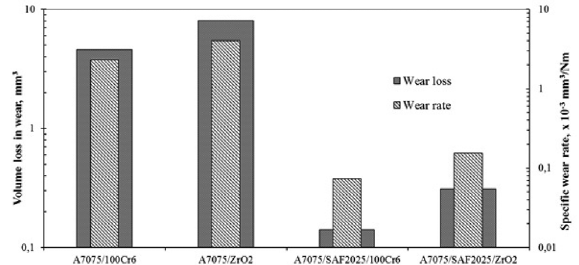
Figure 5: The diagram showing the variation of wear loss and specific wear rate of A7075 and A7075/SAF 2025 composite materials with the interaction of 100Cr6 and ZrO 2 counterpart in dry sliding